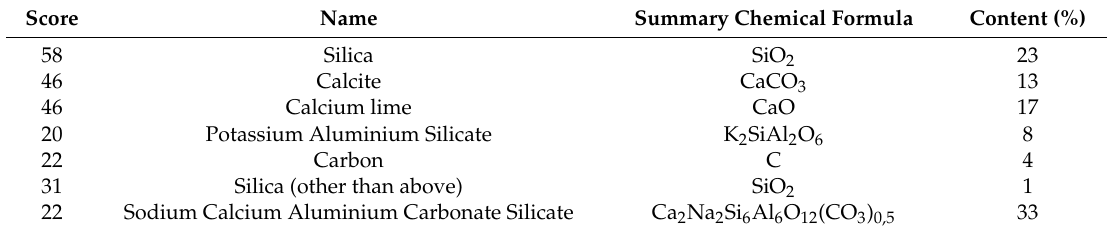
Table 9. X-ray diffraction analysis